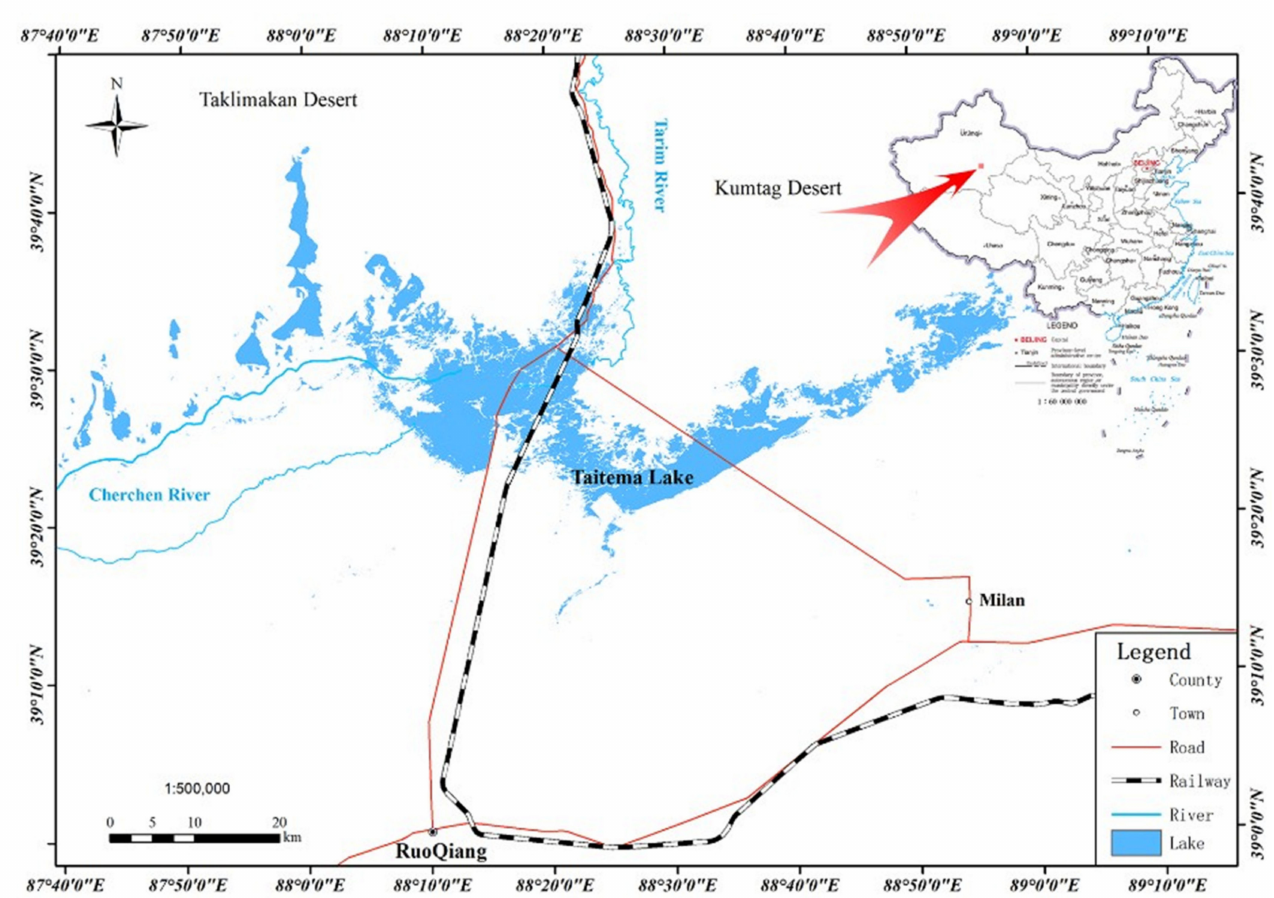
Figure 1. Schematic diagram of the location of Taitema